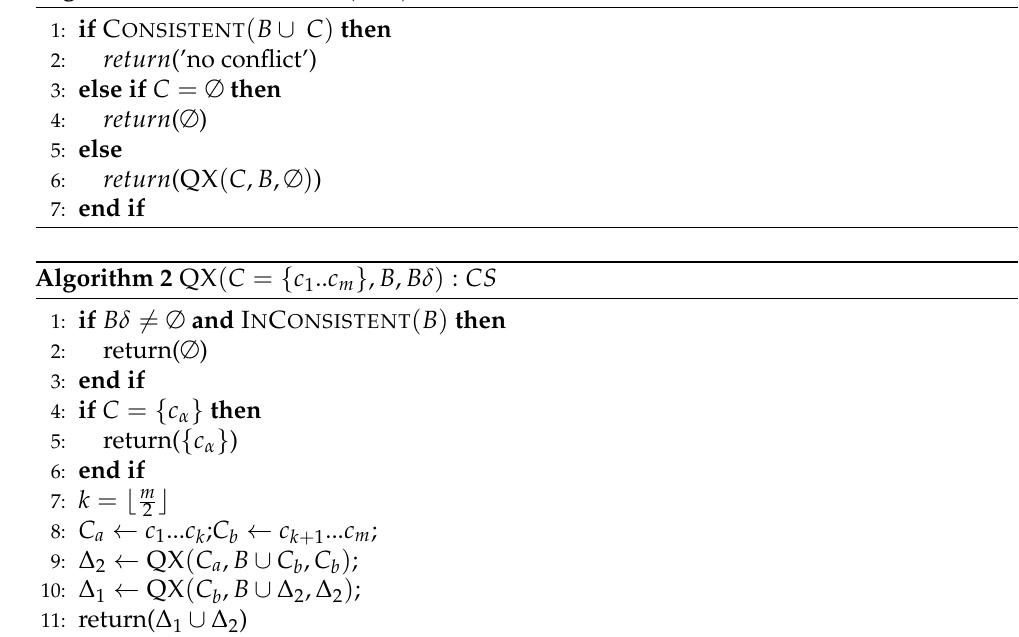
Algorithm 1 Q UICK XP LAIN ( C , B ) : CS